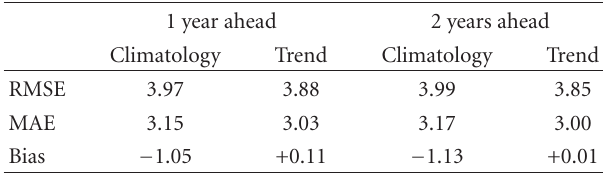
Table 1: Results of hindcasts of station annual minimum tempera-